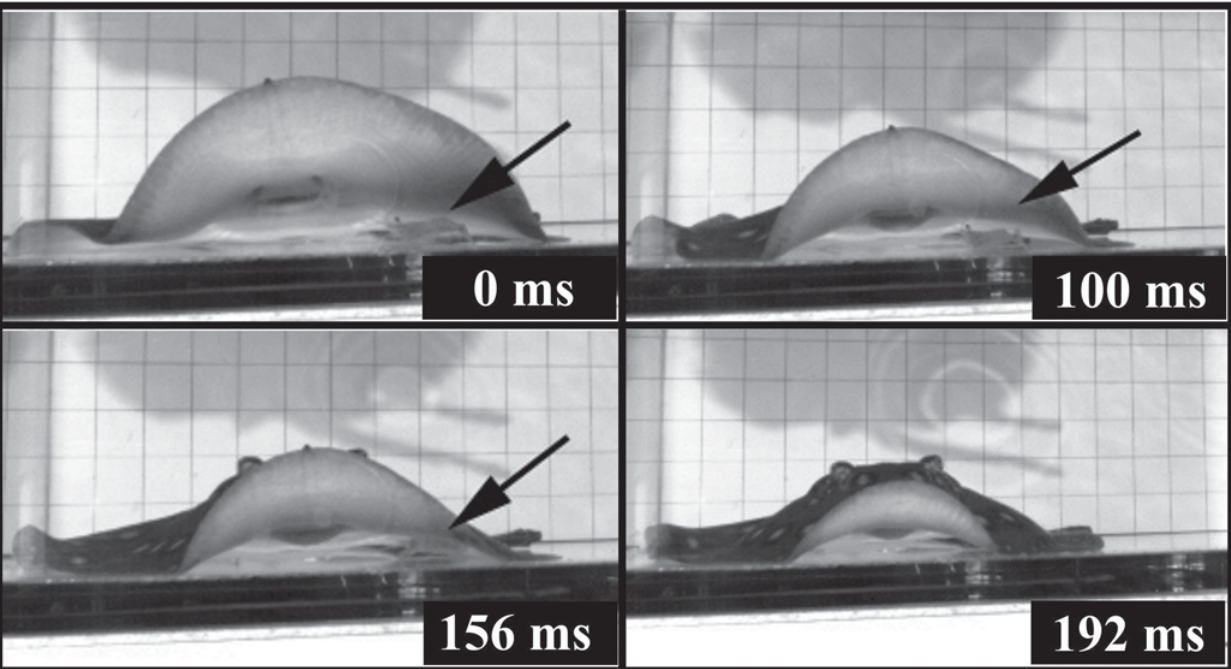
Fig. 3. Sequences of video frames showing the prey capture behavior by Potamotrygon motoro in lateral view. The ray elevates its rostrum (0 ms), which is followed by depression of lower jaw (100 - 156 ms) and rostrum (192 ms) to strike the prey. Arrows indicate the prey